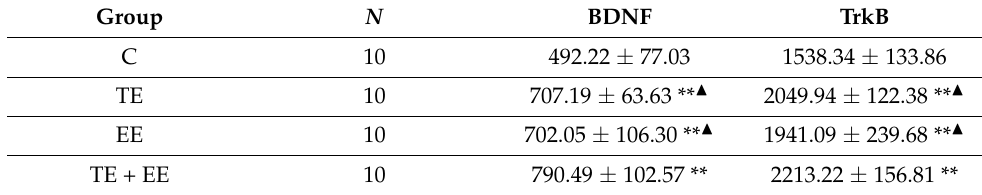
Table 1. Comparison of the plasma concentrations of BDNF and TrkB in the groups ( x ± s ).